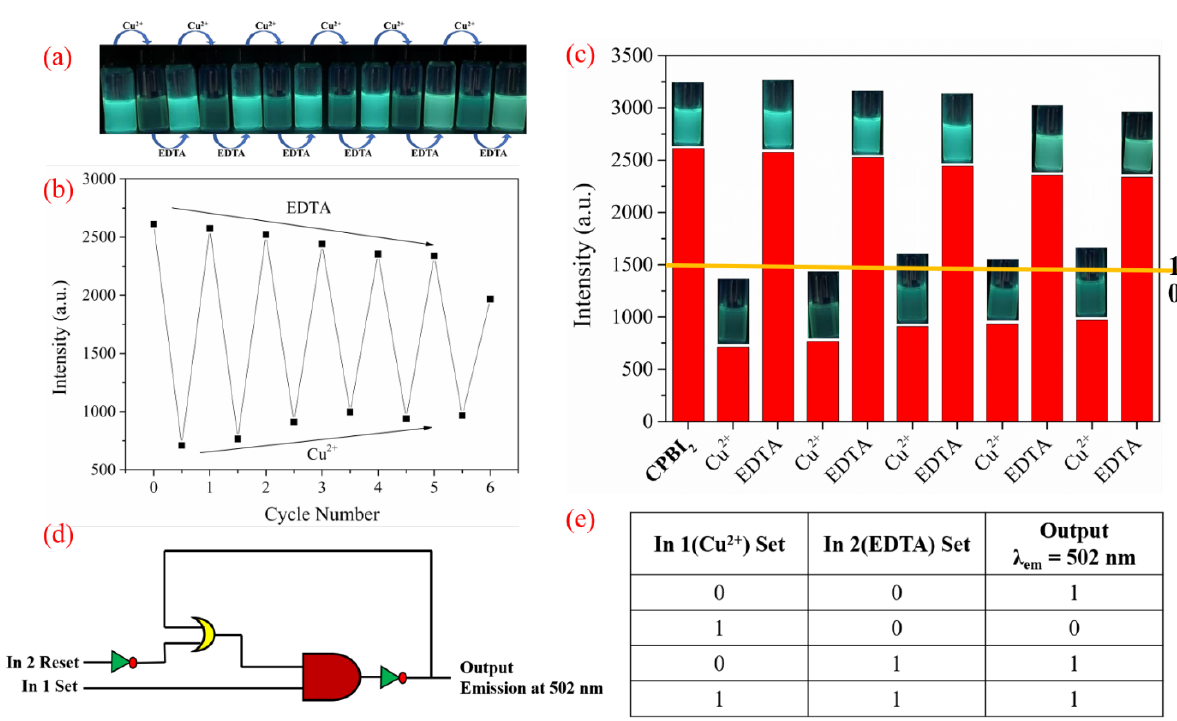
Figure 9. Fluorescence experiment of the probe CPBI 2 in cyclic use: alternately adding Cu 2+ and EDTA into the CPBI 2 solution (λ ex = 375 nm), the color change diagram of the solution under the 365 nm UV lamp ( a ); the fluorescence intensity cycle fluorescence diagram ( b ); input (In 1 = Cu 2+ and In 2 = EDTA) histogram ( c ); implication logic gate ( d ); corresponding truth table ( e ).